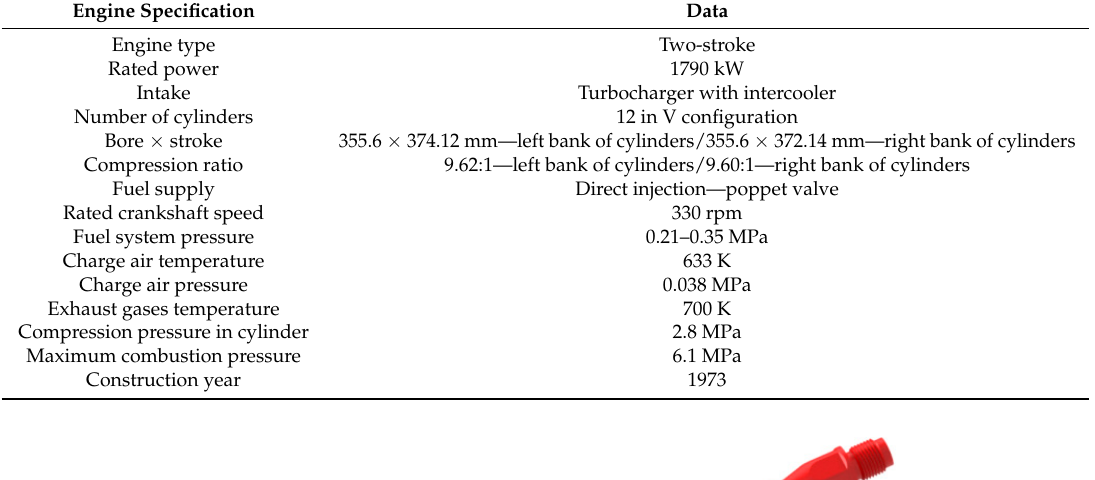
Table 2. Basic parameters of gas engine.